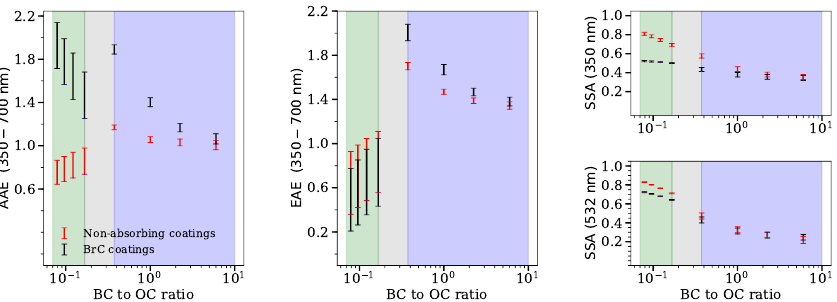
Figure 2. Radiative properties of BC with coatings, D f = 2.2. When BC/OC > 0.375, BC is assumed to be thinly-coated, while BC is assessed to be heavily-coated when BC/OC < 0.167. The green and blue region represent heavily- and thinly-coated BC, respectively, and the gray region represents the transition from thin-coated to heavily-coated. The error bars represent the upper and lower bounds of sensitivity calculations using different size